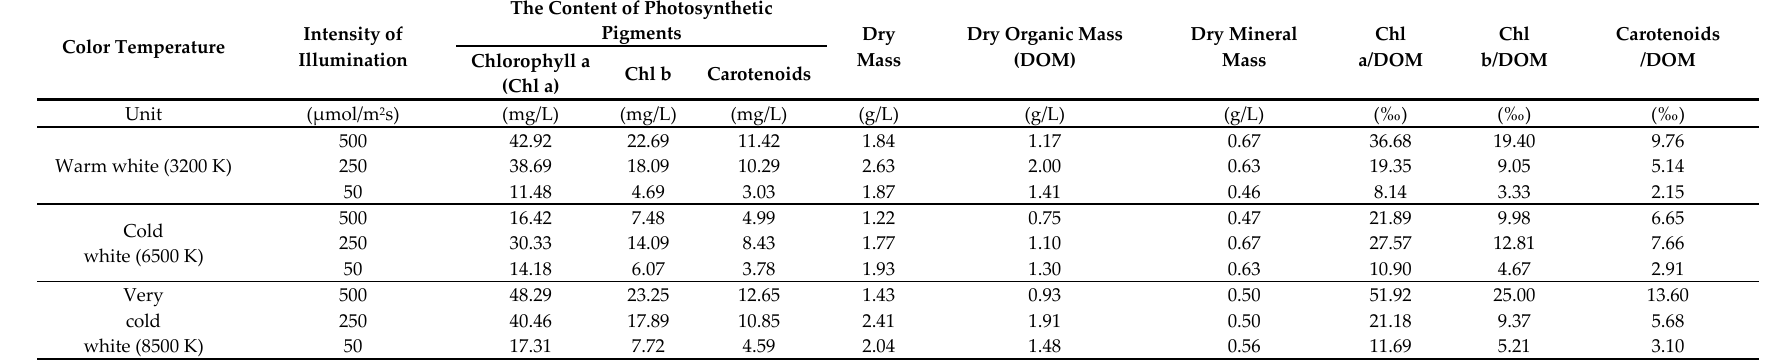
Table 1. Results of testing the content of photosynthetic pigments and the amount of cultured biomass from Chlorella vulgaris algae on day 15 of incubation.